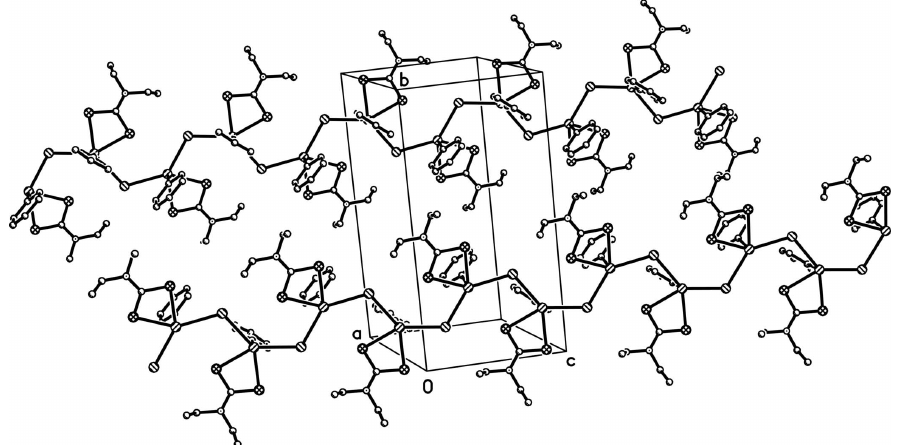
Figure 2 The crystal packing of the title compound, viewed approximately along the a